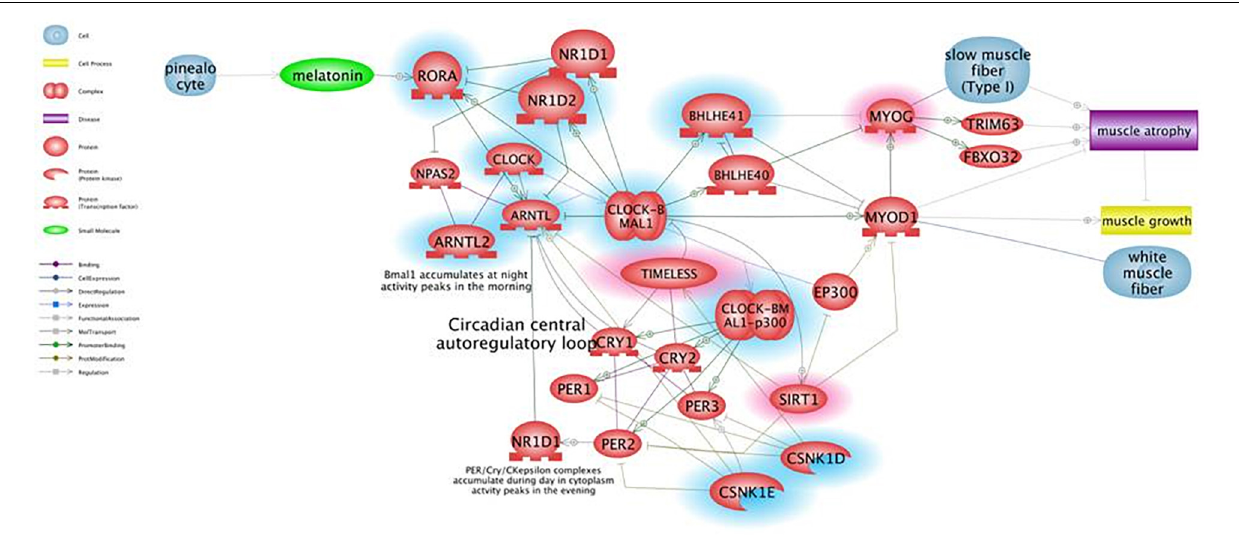
FIGURE 1 | Pathway for circadian rhythm regulation in skeletal muscles and its effect on muscle differentiation and atrophy. Genes that are downregulated in mdx mice more than 2-fold are shown in blue, genes upregulated more than 2-fold are shown in red. Pathway Studio analysis shows that downregulation of the ARNTL1 gene leads to upregulation of MYOG, which is known to be involved in muscle atrophy due to increased expression of ubiquitin ligases TRIM63 and FBXO32, rather than being a clear marker of ongoing regeneration. The ARNTL1-CLOCK1 complex is also repressed by upregulation of the Timeless protein that directly binds and represses CLOCK1, and by downregulation of CSNK1E that activates ARNTL1 directly by phosphorylation and through destabilization of PER1/2 proteins.